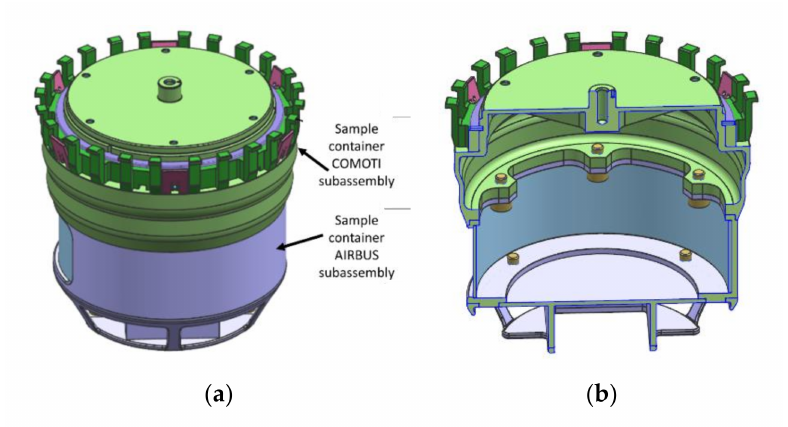
Figure 6. Sample Container: ( a ) isometric view, ( b ) section